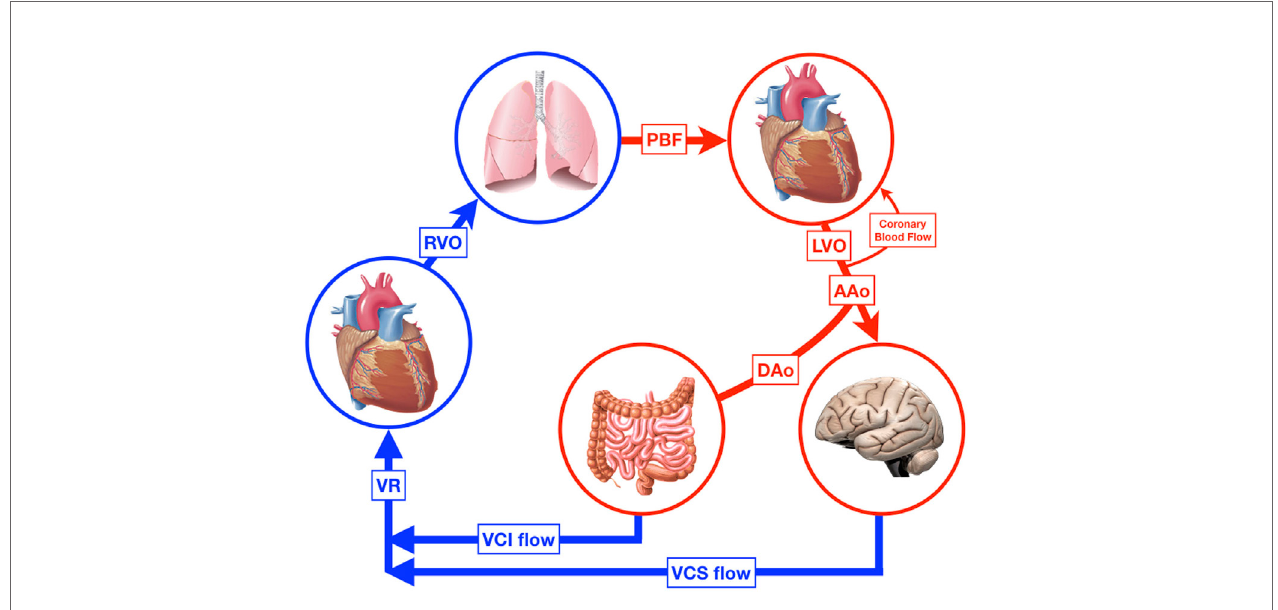
FigURe 2 | The neonatal circulation. RVO, right ventricular output; PBF pulmonary blood flow; LVO, left ventricular output; AAo, blood flow in ascending aorta; DA o , blood flow in descending aorta; DA, ductus arteriosus; VCS, vena cava superior; VCI, vena cava inferior; VR, venous